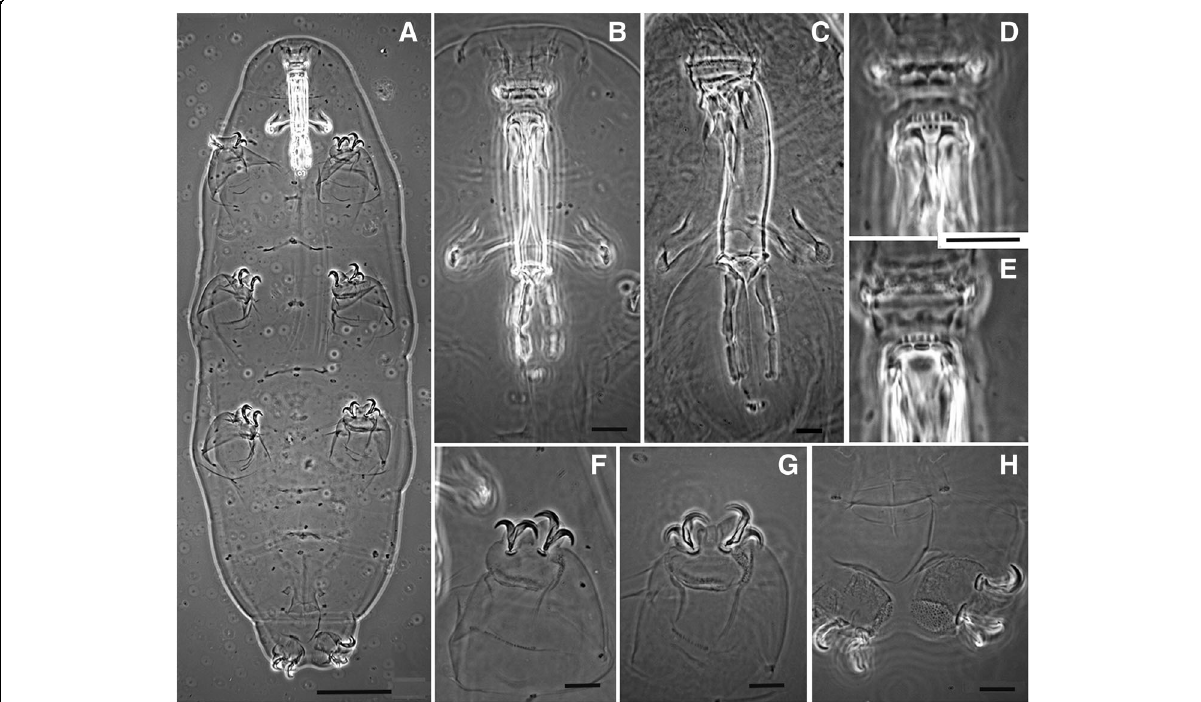
Fig. 2 Paramacrobiotus richtersi (Clare Island) (PhC), neotype ( a , b , d-h ) and a specimen ( c ). a Habitus. b Buccal-pharyngeal apparatus (ventral). c Buccal-pharyngeal apparatus (ventrolateral) d Buccal armature (ventral view). e Buccal armature (dorsal view). f Claws of the first pair of legs. g Claws of the third pair of legs h Claws of the fourth pair of legs. Bars: a = 50 μ m, b - f = 10 μ